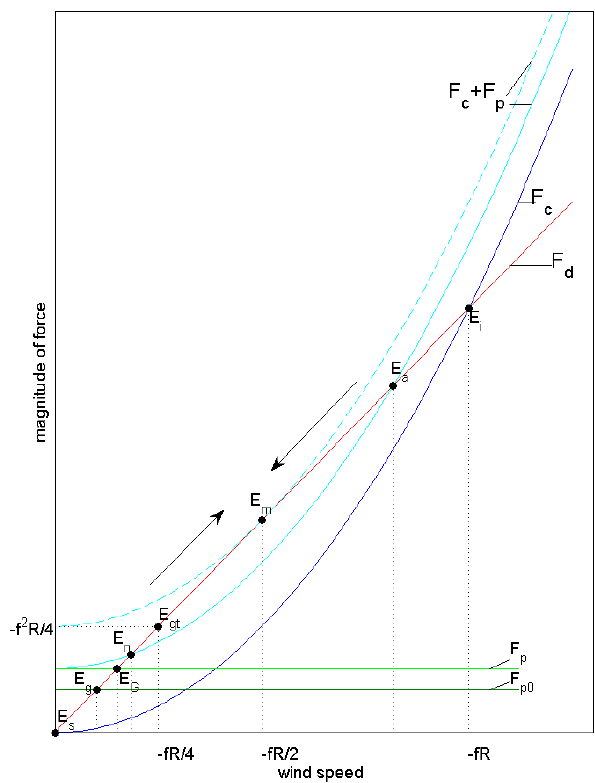
Figure 3. A diagram of the evolution of the normal high and the anomalous high. F p represents the pressure gradient forces and F p0 represents the pressure gradient force of the original geostrophic